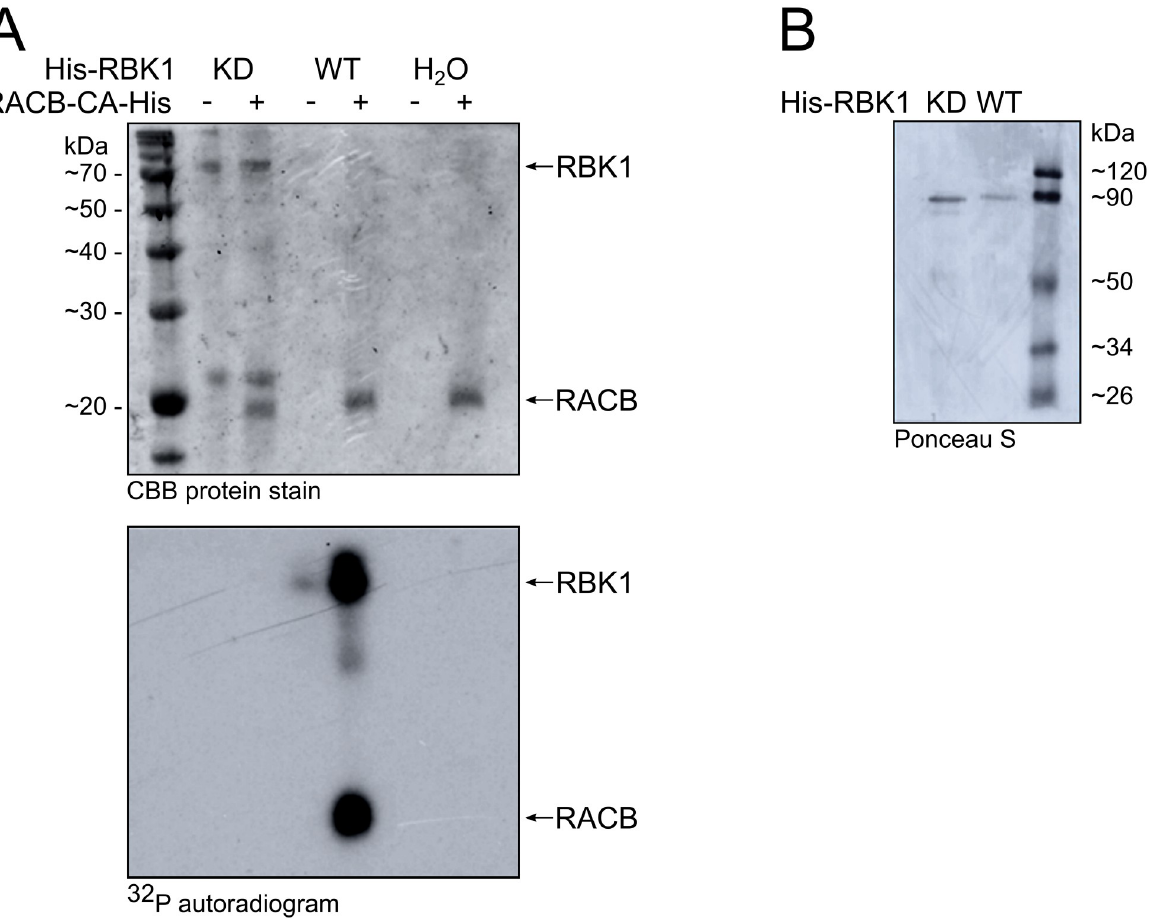
Fig 1. In vitro co-incubation of CA-RACB and RBK1 results in phosphorylation of both proteins. (A) Low amounts of His-tagged RBK1 alone showed weak autophosphorylation in vitro . Kinase activity was enhanced by the presence of constitutively activated His-tagged CA-RACB, resulting in extensive phosphorylation of both proteins. Upper panel = protein loading control. Lower panel = autoradiogram showing 32 P-labelled, phosphorylated proteins. WT = wildtype RBK1; KD = kinase-dead RBK1 loss-of-function mutant (K245D); H 2 O = no kinase control. Estimations of molecular weight are depicted in kilo Dalton (kDa) on the left. (B) Ponceau S stain showing stability of purified WT and KD His-RBK1.